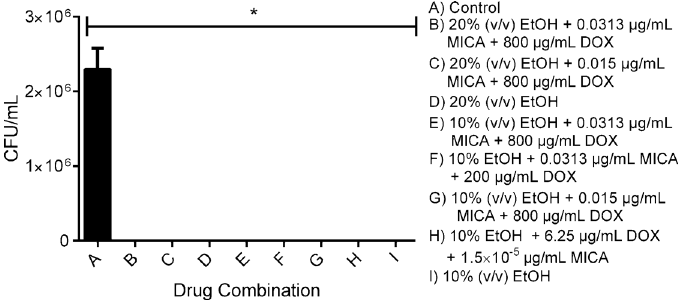
Fig 3. C . albicans SC5314 colony regrowth after 24 hour drug challenge. All combination solutions were highly effective in preventing the regrowth of forming biofilms on silicone. Following 24 hour drug challenge, forming biofilms were sonicated and incubated at 30°C for an additional 24 hours then plated on solid media to quantify regrowth. The untreated control was compared to the drug treated groups using one-way ANOVA. * indicates p value of < 0.05